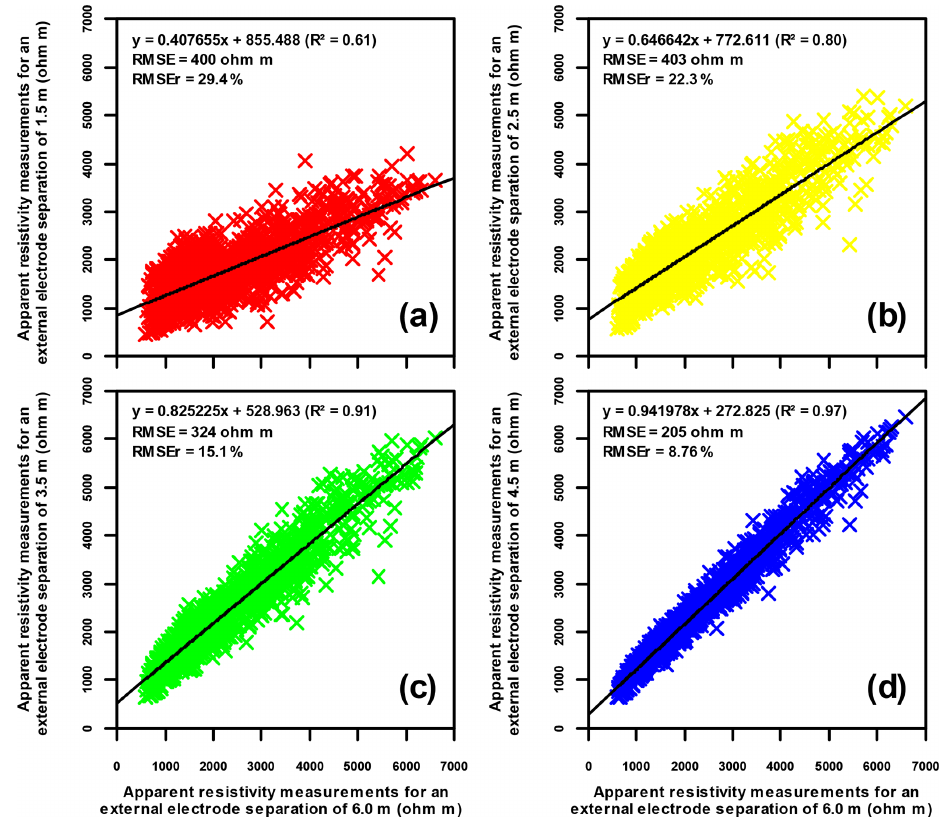
Figure 10. Scatter plots relating the apparent resistivity data corresponding to the first pseudo-depth acquisition level with an ES of 2m (external electrode spacing of 6m) vs. the shallower first four surficial apparent resistivity levels using an ES of 0.5m with external electrode separations of 1.5 (red crosses), 2.5 (yellow crosses), 3.5 (green crosses) and 4.5m (blue crosses) for the 12 plot-scale ERT profiles measured in the Weierbach catchment. Each point of the scatter plots represents the apparent resistivity of one ERT profile, for the same pseudo-x position, but at different pseudo-depths as defined by the external electrode separation (see Sect. 2.3 for more details). The linear regressions correspond to the thick black lines and their accuracy is indicated by the coefficient of determination ( R 2 ), the root mean square error (RMSE) and the root mean square relative error